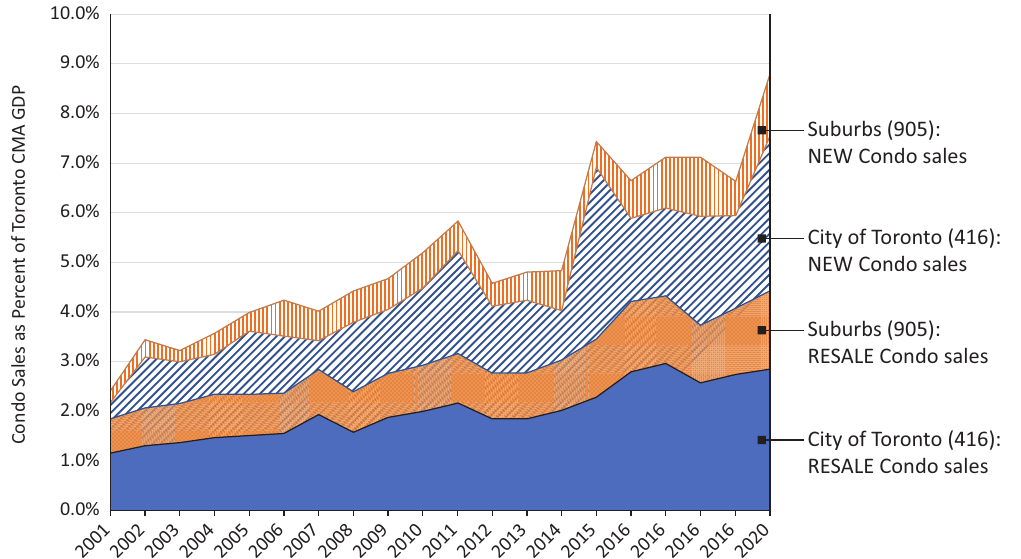
Figure 4. Contribution of condo sales to the GDP of the Toronto CMA, 2001–2020. Note: As the GDP of the Toronto CMA for 2017 and 2018 was estimated to be 49.98% of the Ontario provincial GDP by Statistics Canada, we assume a similar ratio carries forward for 2019 and 2020. Source: Calculated by the authors using data obtained from Altus Group (2020), CMHC (2022), Statistics Canada (1981, 1991, 2001, 2006, 2011, 2016, 2022a), and TRREB (2021).